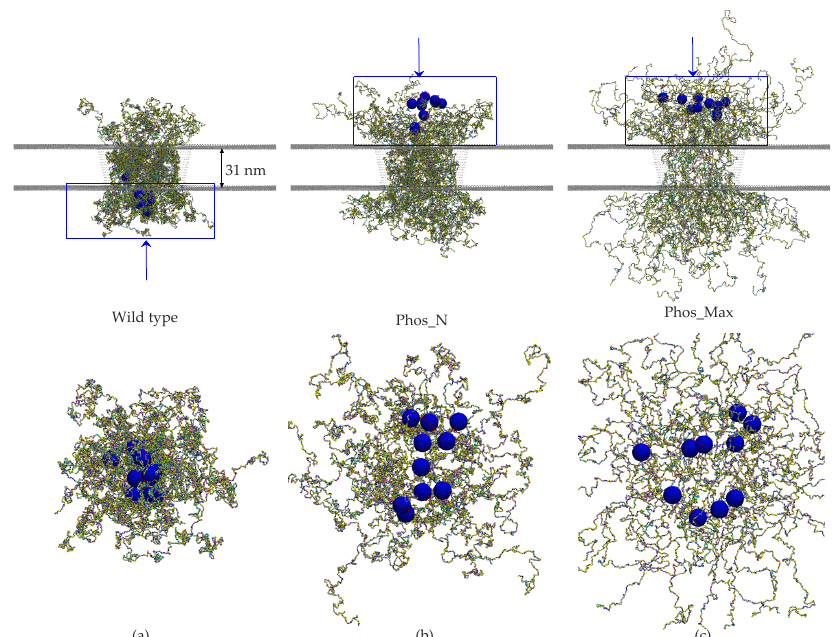
Figure 6. Snapshots at t = 2 µ s of the FG-Nups and model Kap95 particles inside a wild type NPC ( a ), a phosphorylated NPC according to the Phos_N scheme ( b ), and a phosphorylated NPC according to the Phos_Max scheme ( c ). The Kap95 particles are shown in blue with the red hydrophobic binding spots on its surface. The 20 different amino acids of the FG-Nups are represented by different colors. The size of the scaffold beads (grey) is scaled down to make the Kap particles better visible. In the bottom panel we provide a magnified view from the bottom for ( a ) and from the top for ( b ) and ( c ), focusing on the region indicated by the blue boxes in the top panels. The Kaps are shown to traverse the wild type NPC, whereas the Kaps are not able to strongly partition into the FG-Nup meshwork for the phosphorylated